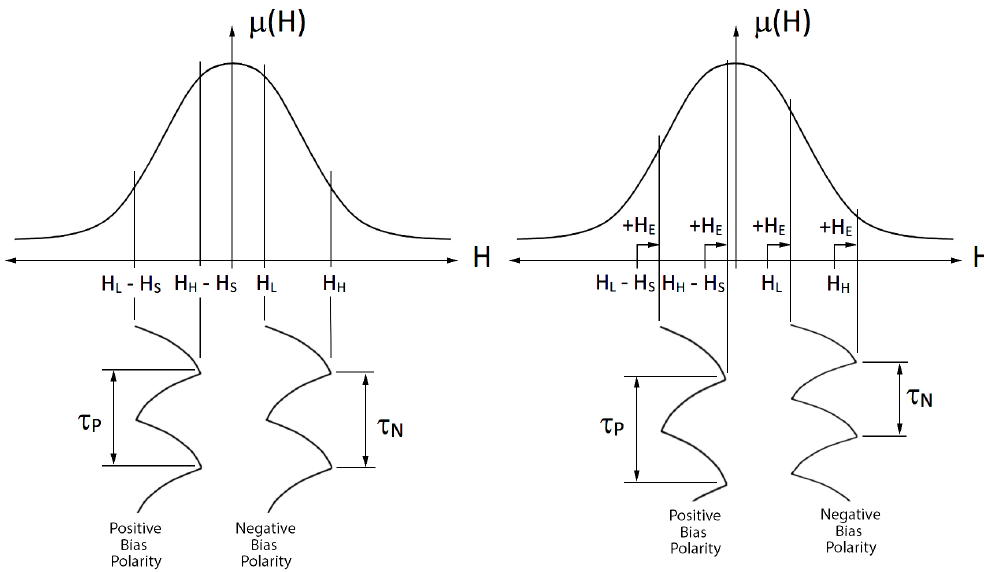
Figure 2. Permeability curve of the core material of the sensors, showing the region of operation and difference in charge and discharge times in the absence (left) and presence (right) of an external magnetic field (from Leuzinger and Taylor, 2010).